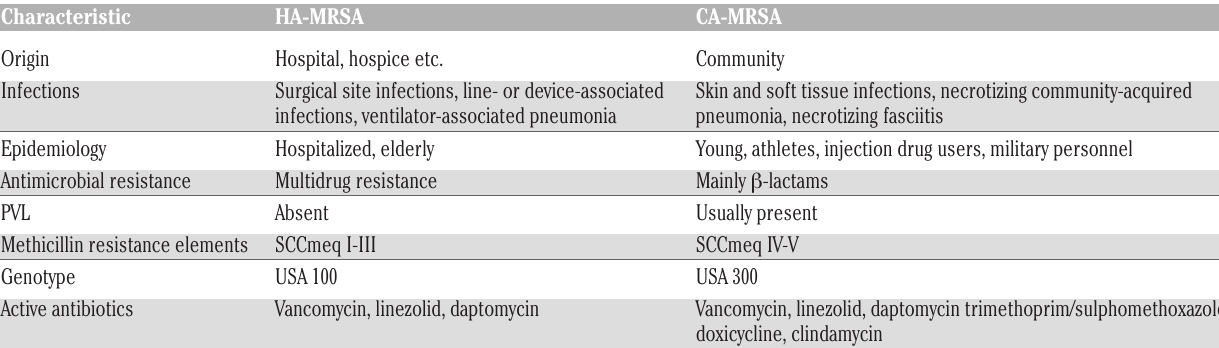
Table 1. Main characteristics of HA-MRSA and CA-MRSA